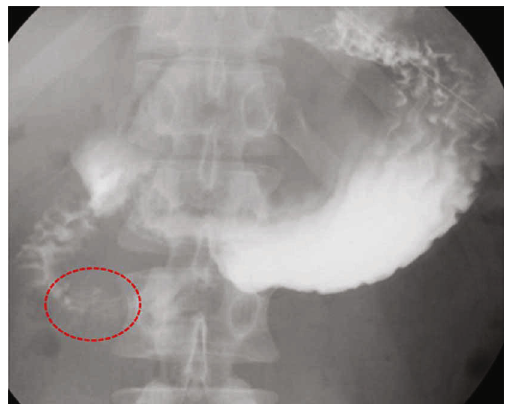
Figure 4: Upper GI series revealed a passage disorder of the duodenal descending portion (dotted